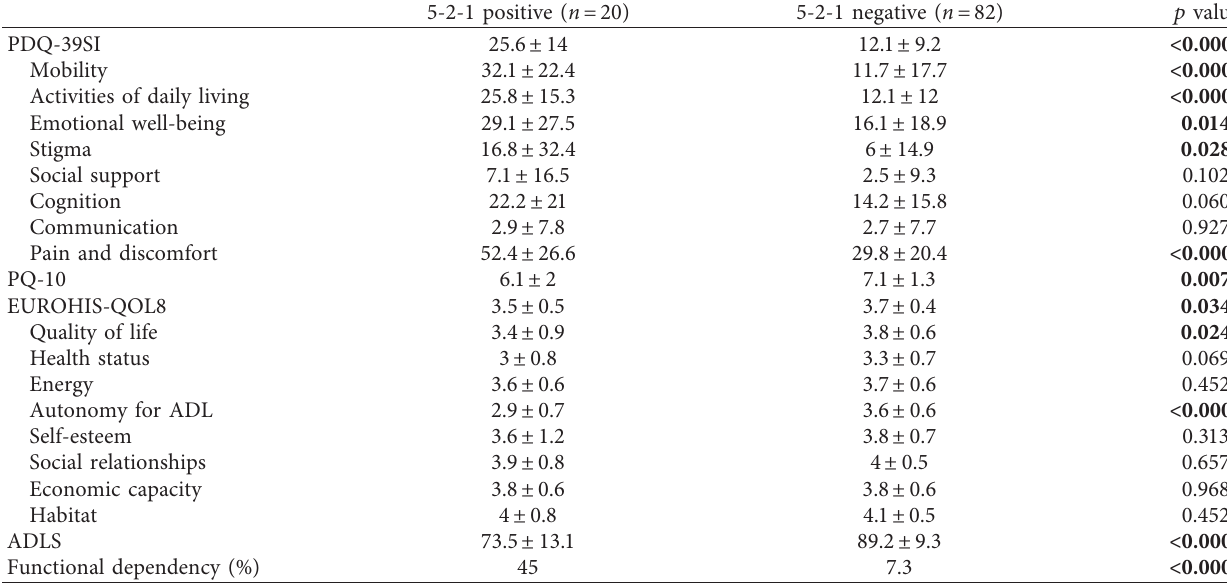
Table 2: QoL and autonomy for activities of daily living in patients with 5-2-1 criteria ( n � 20) vs those with 5-2-1 negative criteria ( n � 82).